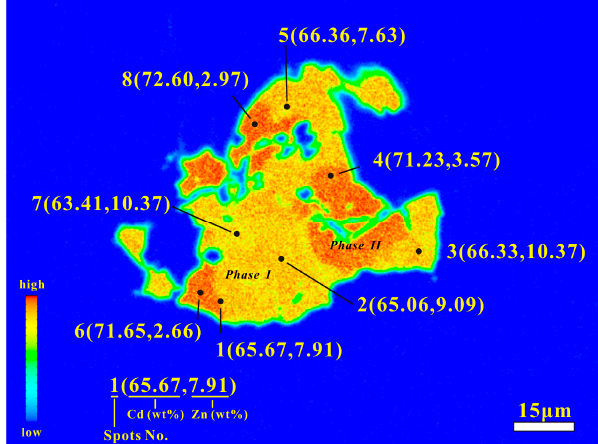
Figure 9. Enlargement of Figure 7f showing the electron-probe microanalysis data of Cd and Zn in Phase I and Phase II of zincian greenockite. Spots 1, 2, 3, 5, & 7 are from Phase I (light yellow areas) and possess less than 67 wt % Cd, and spots 4, 6, & 8 are from Phase II (dark red areas) and possess more than 71 wt % Cd.